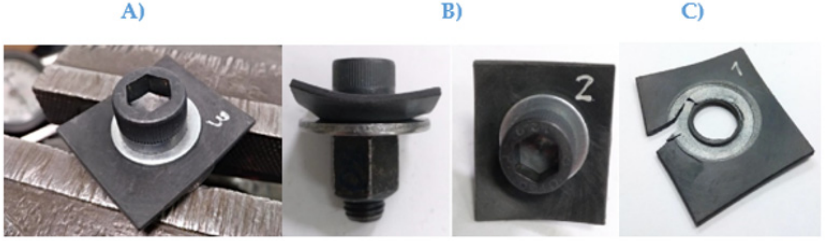
Figure 3. PA66 FG30 ( A ) Prior to the test, ( B ) Deformation at 60 Nm and breakage at 80 Nm. ( C ) Crack at 60 Nm.